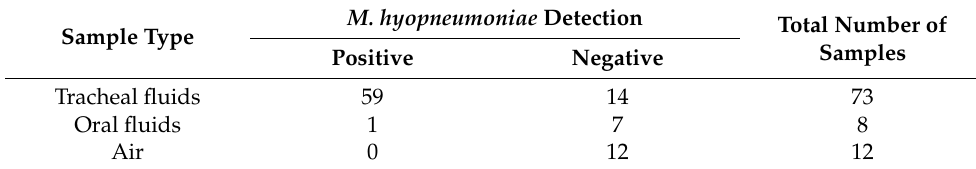
Table 1. Distribution of Mycoplasma hyopneumoniae detection in study fluids and samples.